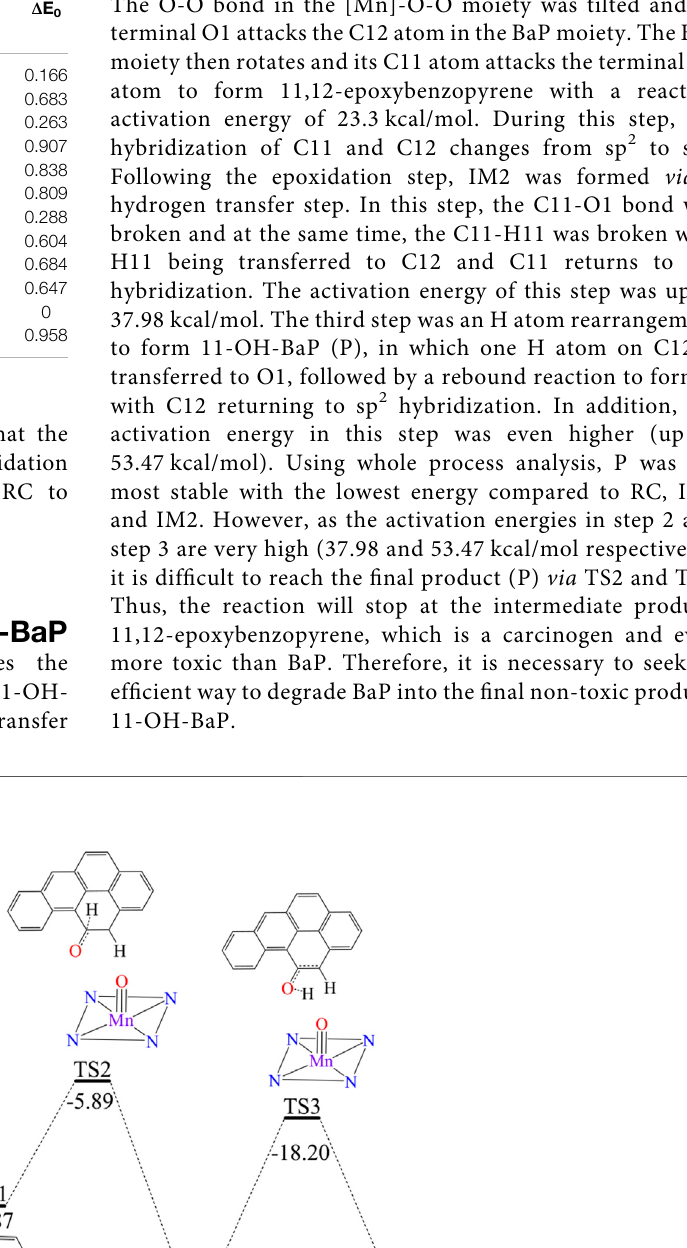
Frontiers in Chemistry |